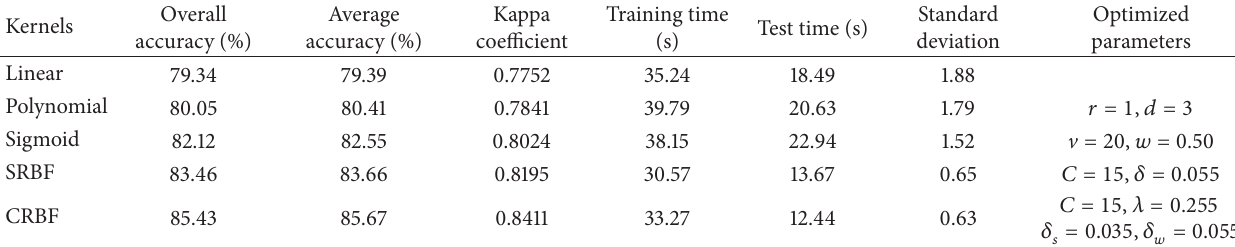
Table 6: Comparison of BDT-SMO classification approaches under different kernels (zone 1).